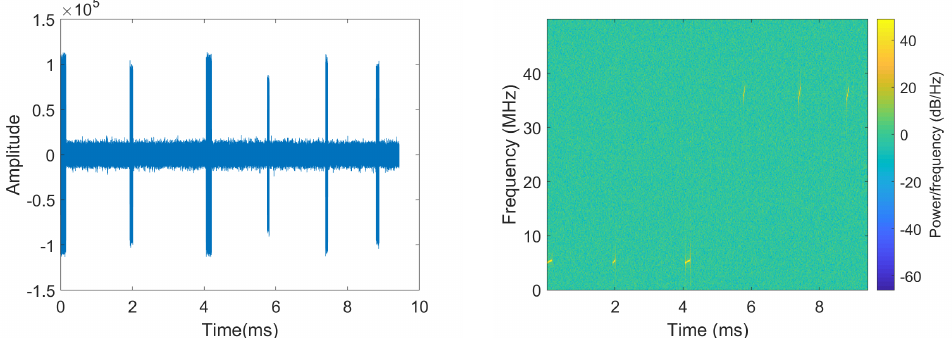
Figure 12. Time domain waveform and spectrogram of direct wave IF signal.